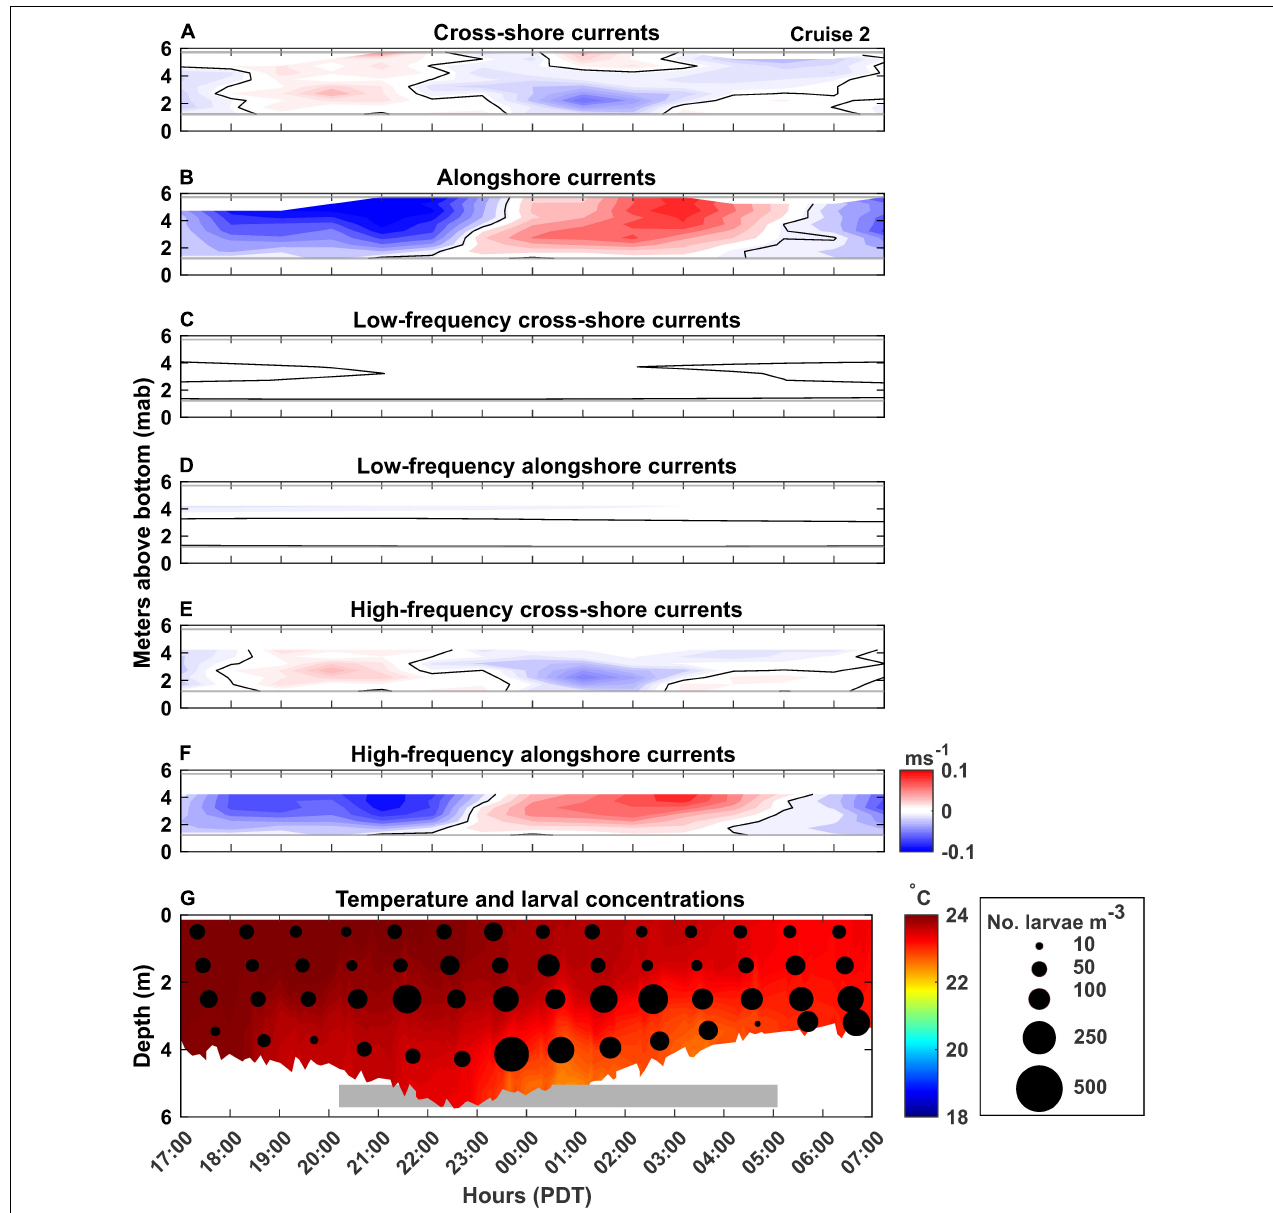
FIGURE 3 | Cruise 2 (July 25–26, 2017) currents, temperature and C. fissus larval concentrations. Figure details are the same as Figure 2